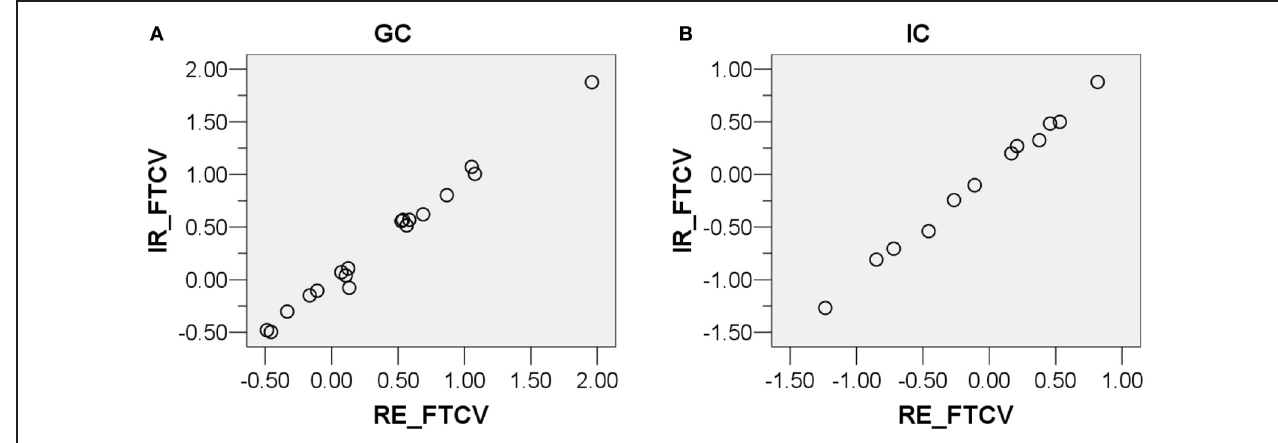
Innocent Condition responding to relevant sub-questions ( X -axis) and irrelevant sub-questions ( Y -axis). The facial temperature change value in degrees Celsius ( ◦ C).